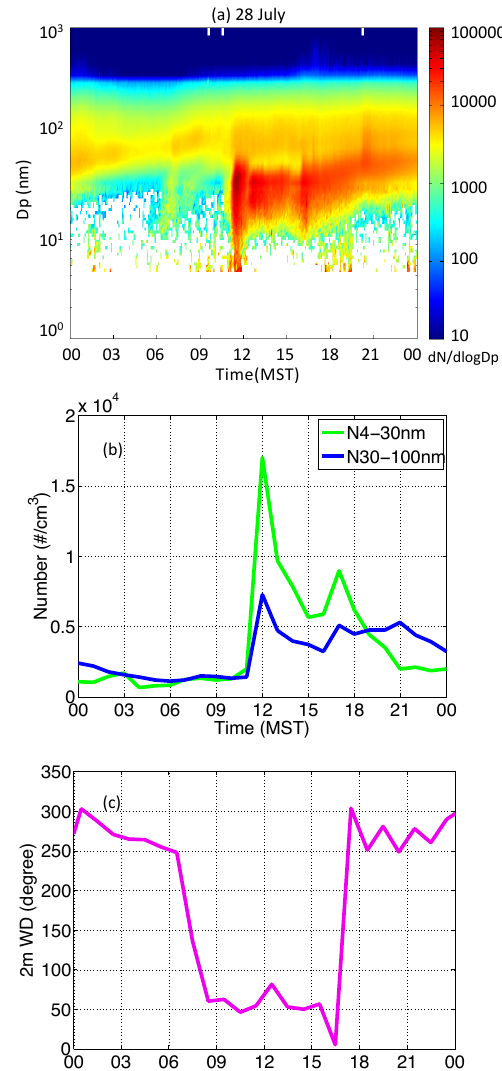
Figure 3. 28 July: (a) shows the diurnal cycle of the number size distributions. (b) shows the diurnal cycle of number concentrations for particles from 4 to 30nm and 30 to 100nm. (c) shows the diurnal cycle of wind directions at 2 m.